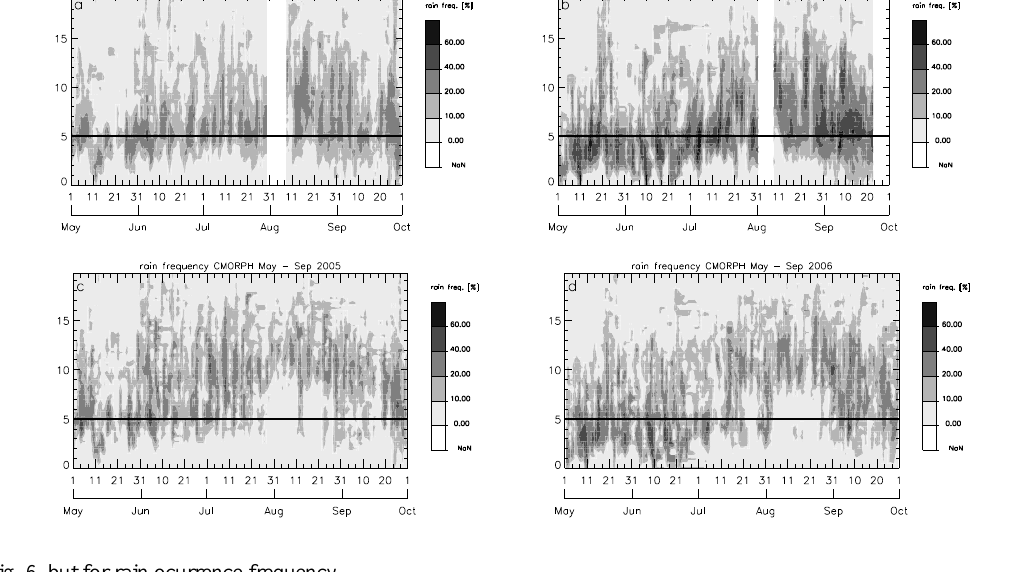
Fig. 8. As Fig. 6, but for rain ocurrence Fig. 8. As Figure 6, but for rain ocurrence frequency.